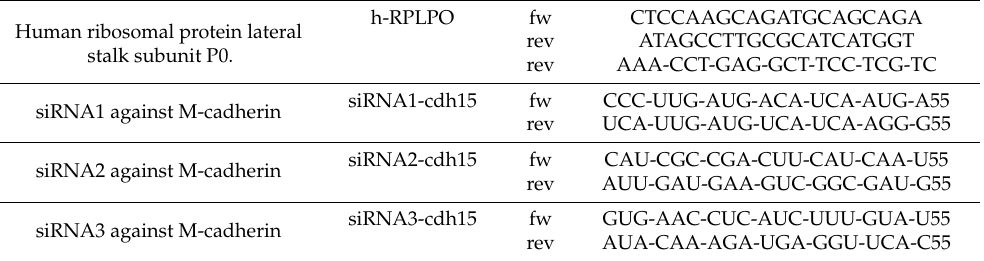
Table 1. Primer and siRNA sequences. Human ribosomal protein lateral stalk subunit